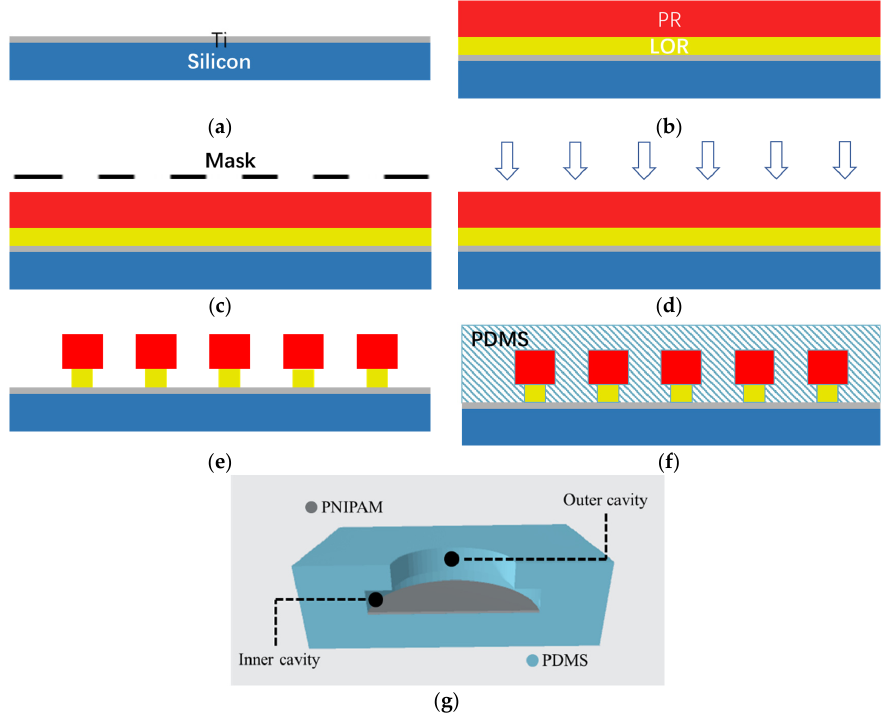
Figure 1. The biomimetic octopus sucker structure preparation process: ( a ) Silicon wafer coated with Ti film; ( b ) PR and LOR photoresist spin coating; ( c ) UV mask exposure; ( d ) UV flood exposure; ( e ) positive photoresist developing; ( f ) PDMS pouring onto the formwork; ( g ) Section view of the cavity structure after PDMS demolding and PNIPAM coating.